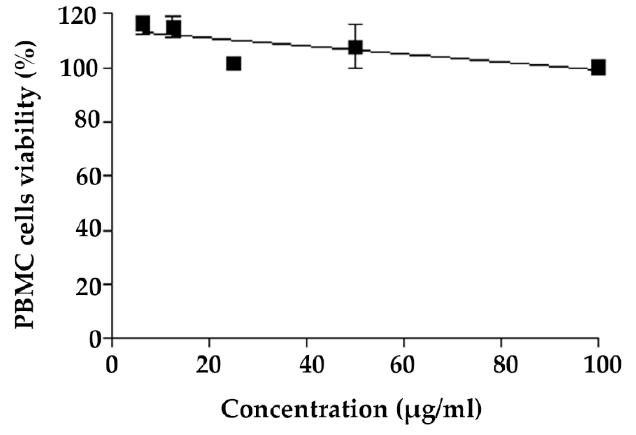
Figure 2. Dose–response curves of viability of PBMC versus concentration of AGO.